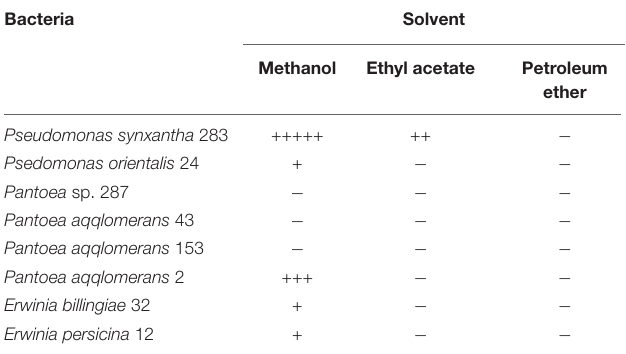
TABLE 4 | Effect of different solvents on the extraction efficiency of active compounds.